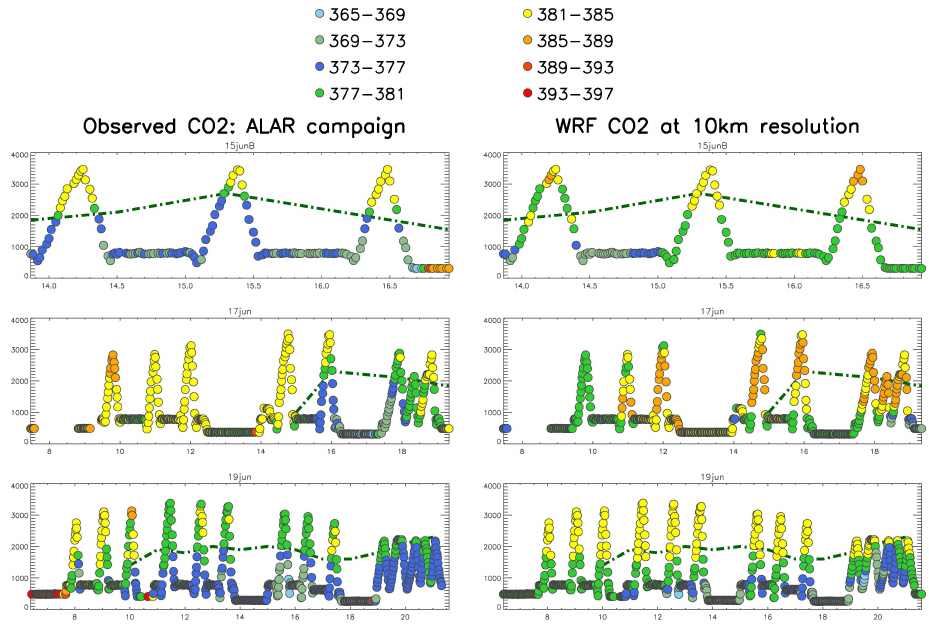
Fig. 3. CO 2 concentrations observed during several flights of the ALAR campaign for 15, 17 and 19 June (on the left) compared to WRF- ChemCO 2 concentrations using SiBcrop fluxes (=before flux optimization) (on the right). Colors indicate the mixing ratio range in ppm. The top of the PBL is indicated by the large vertical gradients from low to high mixing ratios in the free troposphere (green dashed line). The differences between observed and simulated PBL heights are large during transition periods (mornings), overwhelming signals during nighttime, but are low during daytime (afternoons), ranging from 10 to 15% of the PBL height.